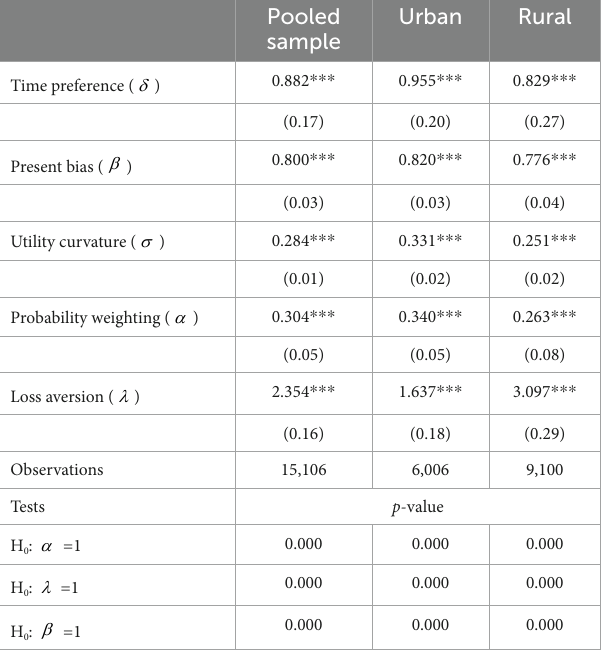
TABLE 3 Estimates of risk and time